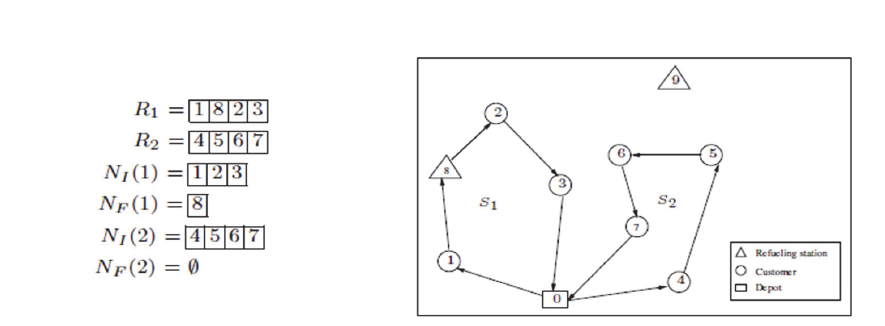
Fig. 1. An example of G-VRP solution